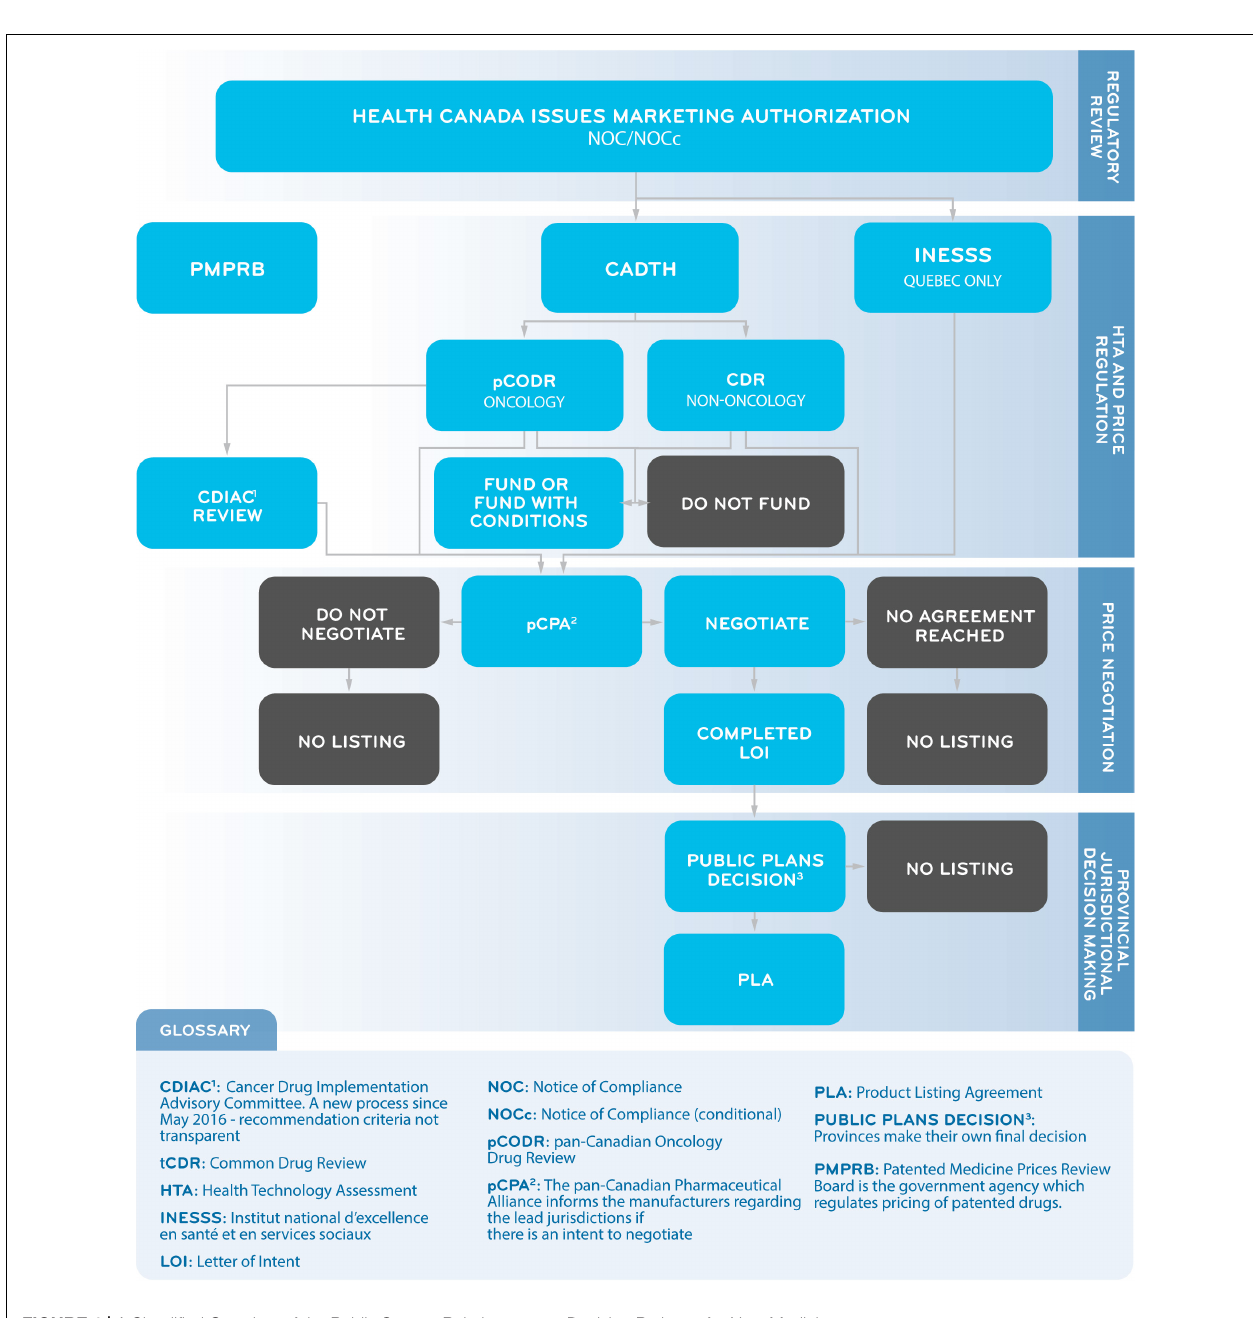
FIGURE 1 | A Simplified Overview of the Public System Reimbursement Decision Pathway for New